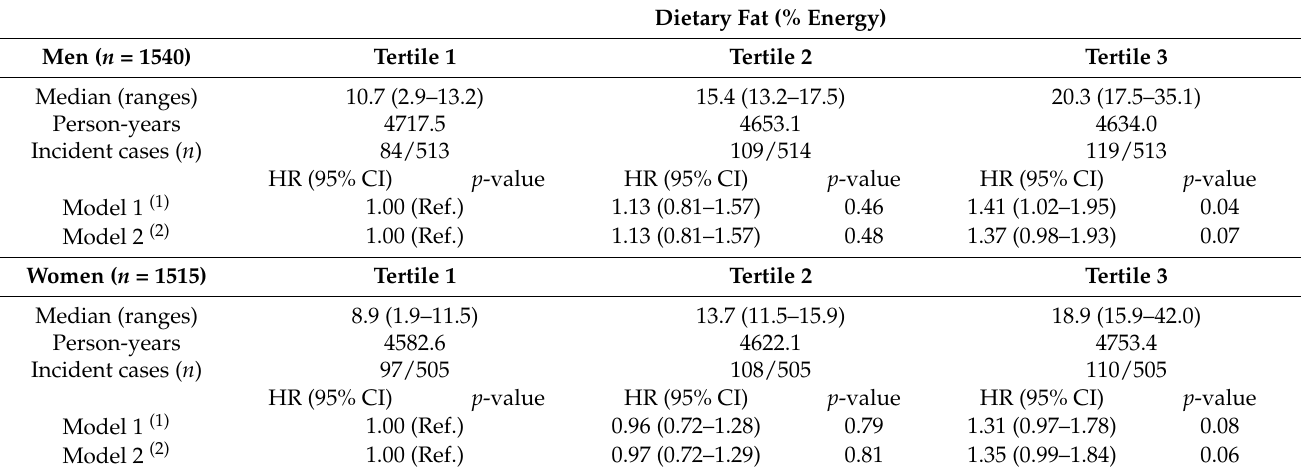
Table 4. Association between tertiles of dietary fat intake and incidence of obesity.